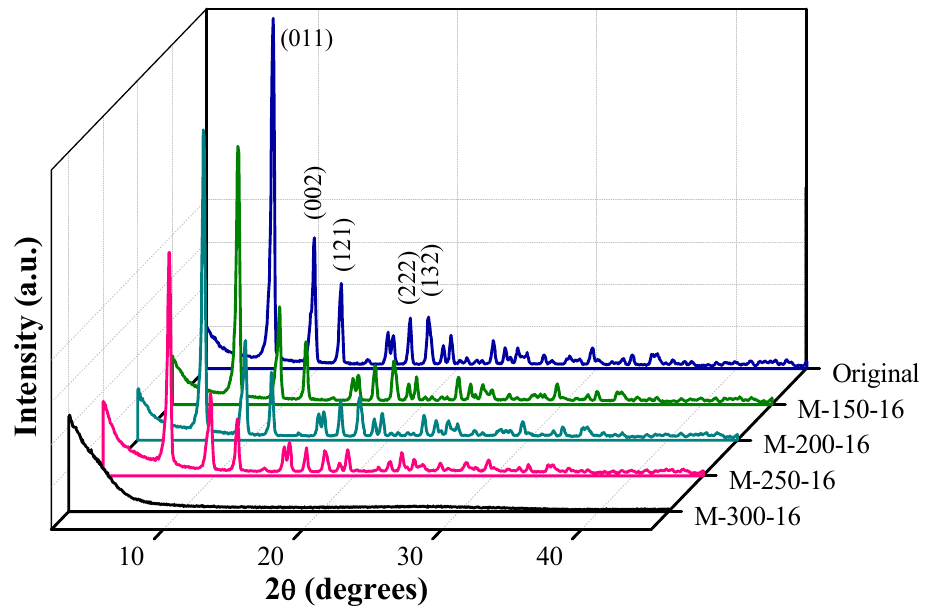
Figure 6. XRD diffraction patterns of NH 2 -MIL-125(Ti) heated in air at different temperatures for 16 Figure 6. XRD di ff raction patterns of NH 2 -MIL-125(Ti) heated in air at di ff erent temperatures for 16 h. h. The original NH 2 -MIL-125(Ti) pattern is included as reference. The original NH 2 -MIL-125(Ti) pattern is included as reference.